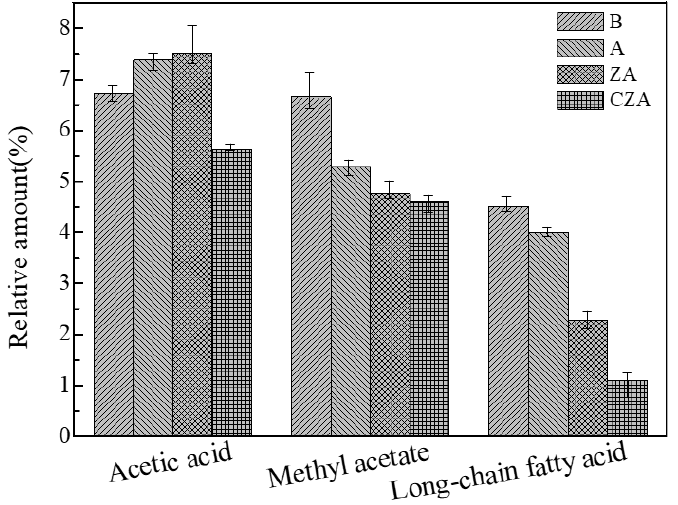
Figure 7. E ff ects of the catalysts on the acid Figure 7. Effects of the catalysts on the acid compounds.